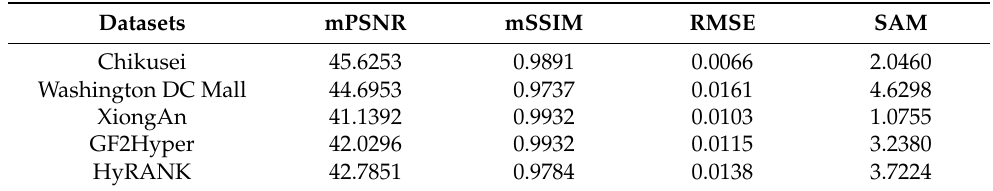
Table 6. Quantitative results of fine-tuned model by fixed masking strategy with three channel inputs. The model is trained with three channel inputs.